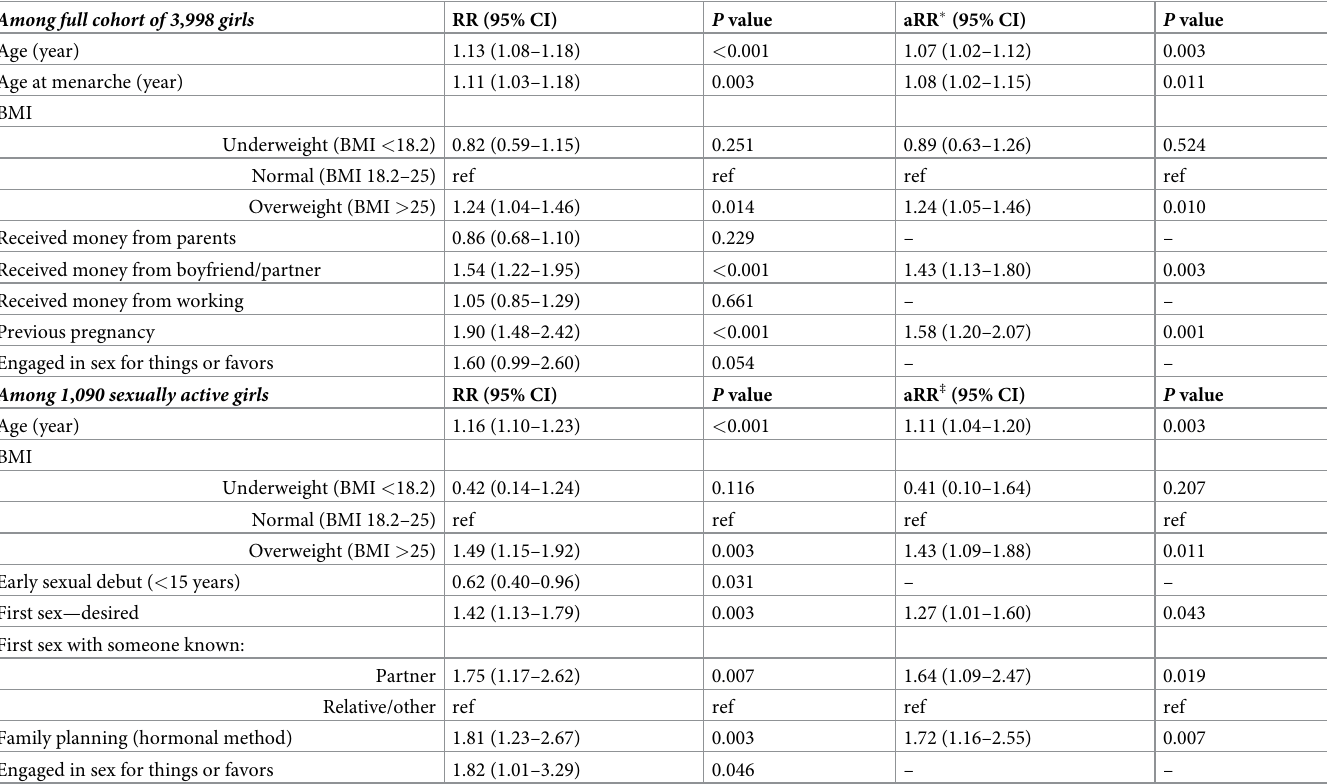
Table 5. Relationship between individual and partner risk factors and HSV-2 seropositivity among adolescent girls attending secondary school, Siaya County, west- ern Kenya,